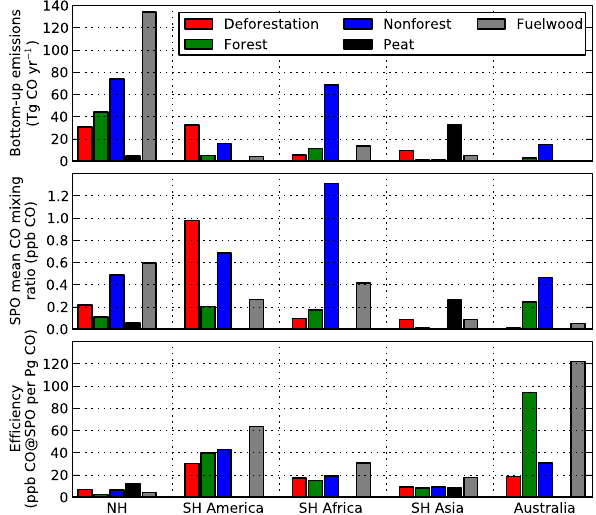
Fig. 9. GFED3 CO emissions estimates for various regions and sources (top panel), the resulting CO mixing ratio at SPO (middle panel), and the ratio between emissions and SPO mixing ratios as a measure of how much the various sources contribute to SPO mix- ing ratios, relatively. NH is Northern Hemisphere, SH is Southern Hemisphere. See also Table